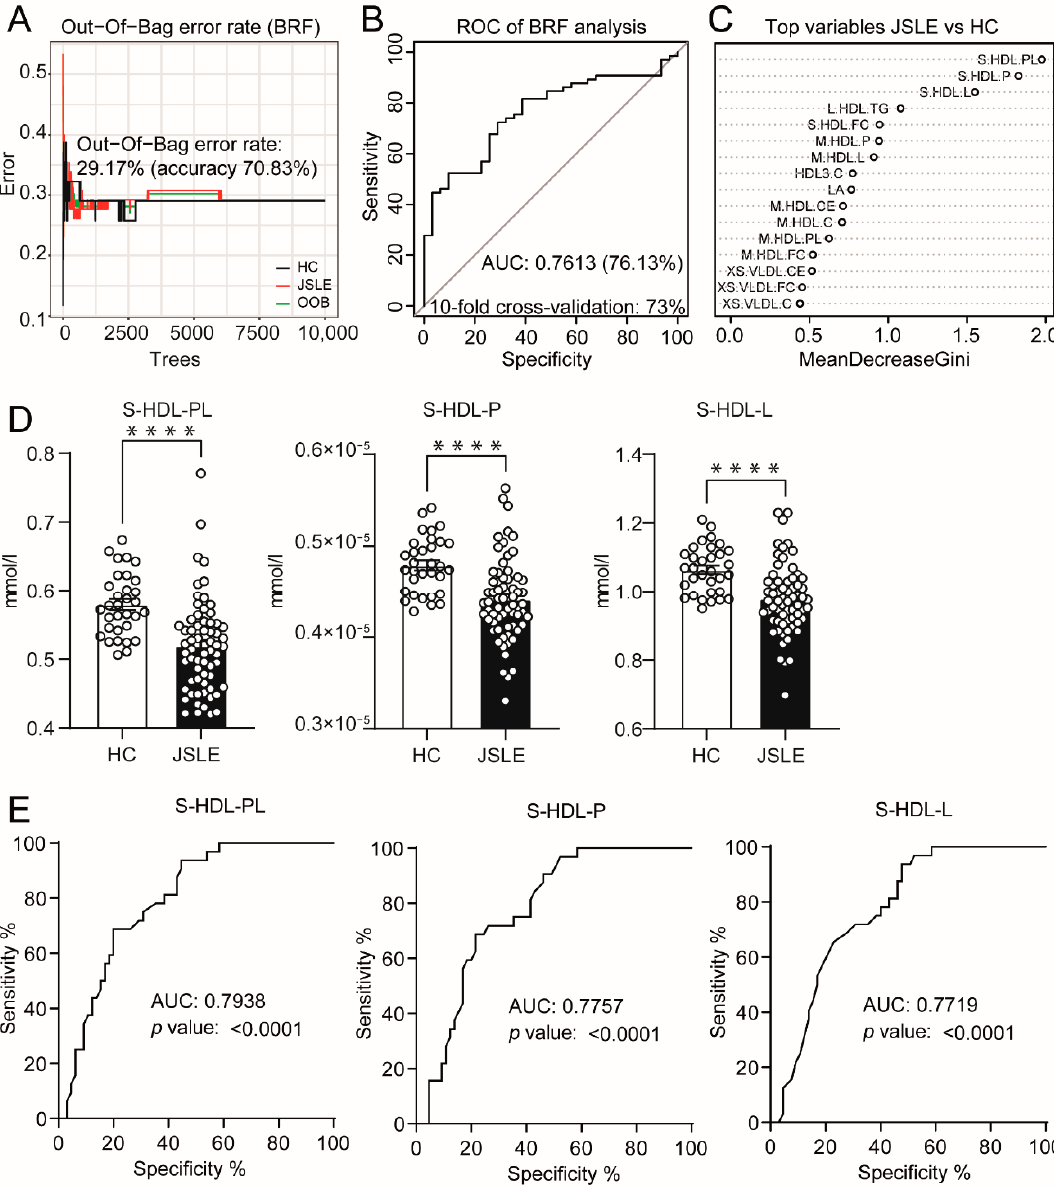
Figure 1. Dyslipidaemia in JSLE is associated with reduced atheroprotective small HDL lipoproteins. ( A – C ) Comparison of 130 different lipid metabolites (Supplementary Table S1) in healthy controls (HCs, n = 32) versus juvenile-onset SLE (JSLE, n = 67) using the balanced random forest (BRF) machine learning model as described in the methods. Demographic variables including gender, age, and race were adjusted in the model. ( A ) The out of bag (OOB) error rate was 29.17%. ( B ) Reciever operator characteristic (ROC) curve analysis and 10-fold cross validation was used to validate the